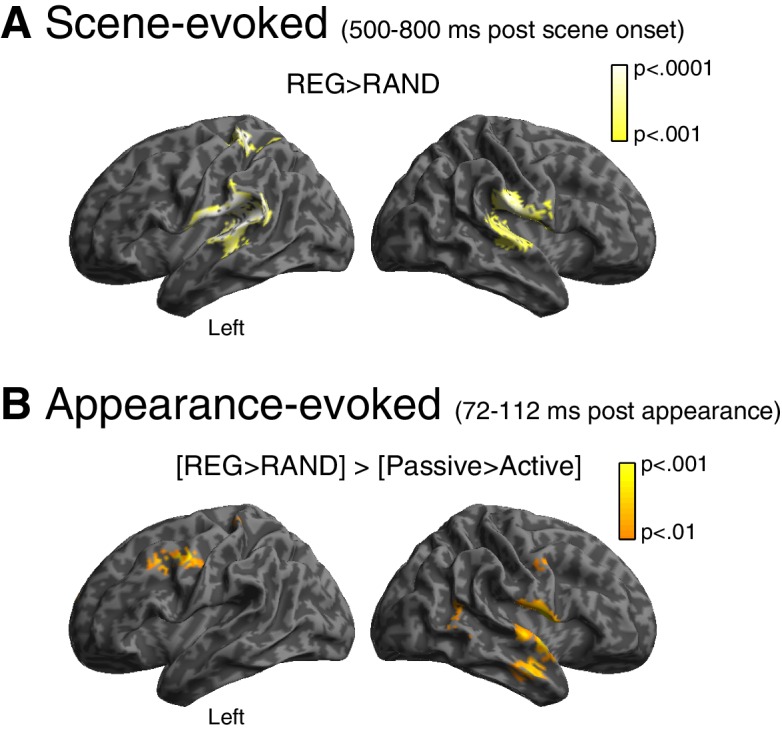
Source reconstruction.(A) Main effect of scene temporal structure at the time of the sustained portion of the scene-evoked response (500–800 ms post scene onset). Statistical map is overlaid onto an MNI space template brain, viewed over the left and right hemispheres. Color-bar indicates statistical threshold. (B) [REG>RAND]>[Passive>Active] interaction at the time of the appearance-evoked M50 component (72–112 ms post appearance).